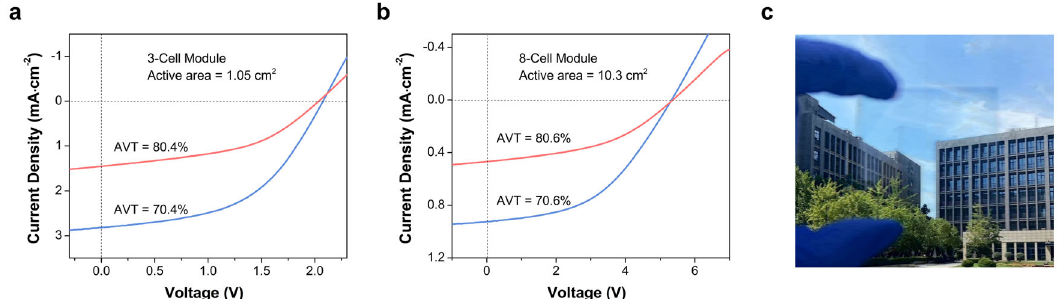
Fig. 5 Photovoltaic properties of the TPV module. J – V characteristics for TPV with active area of 1.05 cm 2 ( a ) and 10.3 cm 2 ( b ). c Photograph of TPV module with AVT of